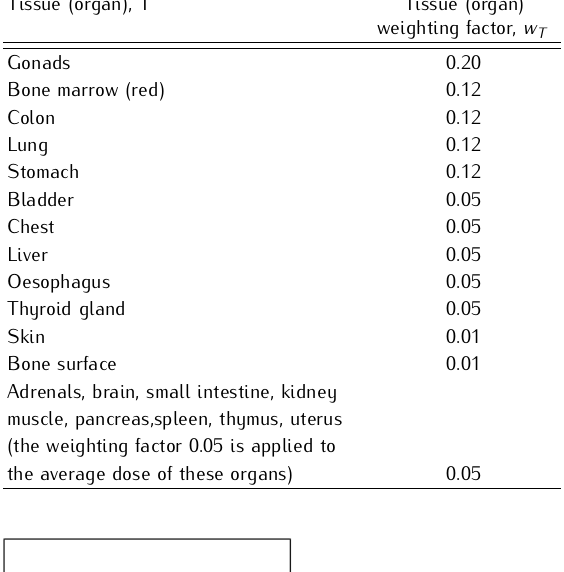
Table 2. Tissue weighting factor w